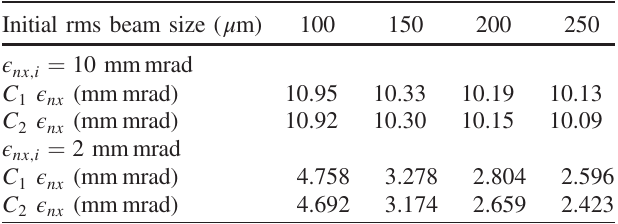
TABLE III. Normalized emittance in horizontal plane after propagation through APL with different initial beam sizes. The vertical emittance is almost identical to that in the horizontal plane. C 1 is the case with considering the proton bunches and C 2 is the case without considering the proton bunches.